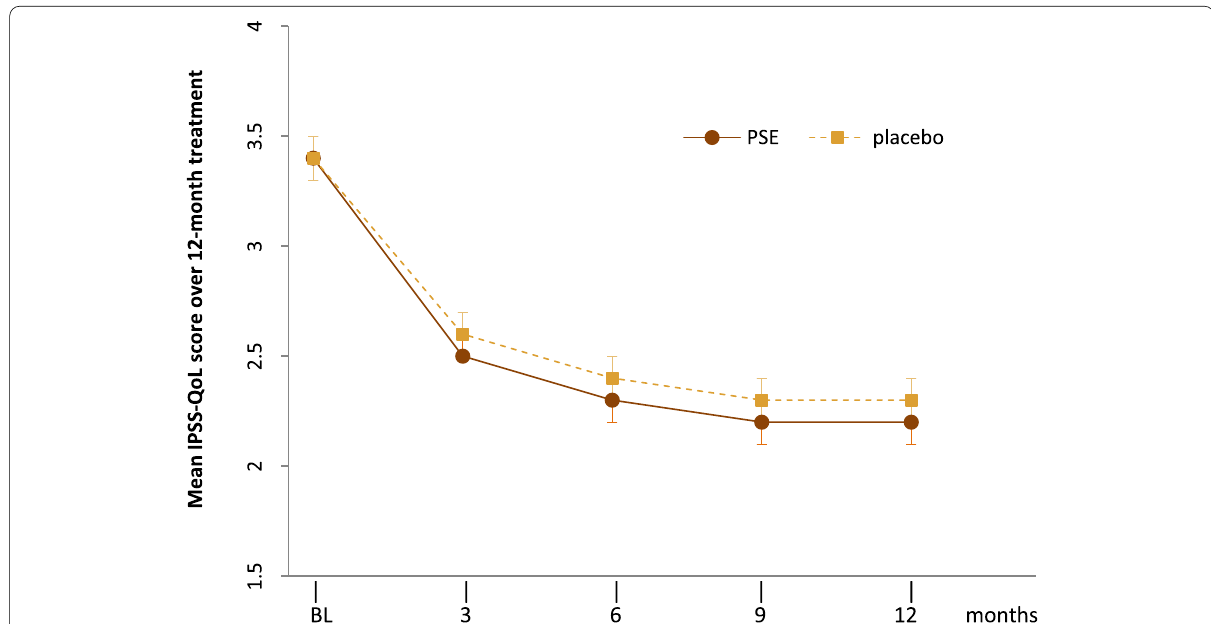
Fig. 5 IPSS QoL score during 12-month treatment (ITT set). Bars indicate 95% confidence intervals. BL baseline; PSE pumpkin seed soft